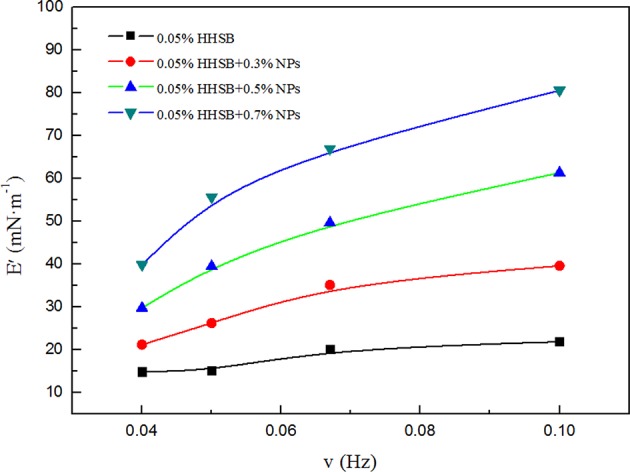
Dilatational surface elasticities E as a function of frequency for SC-CO2 foams with different nanoparticles at 70°C and 8 MPa.